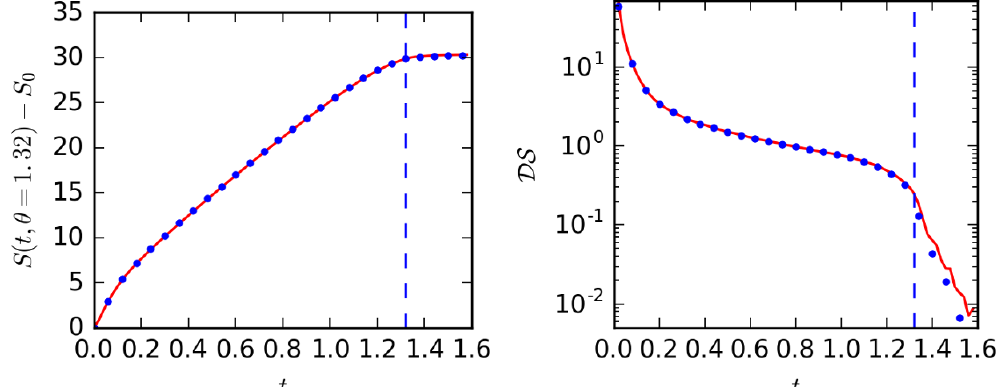
Figure 3 . Entanglement entropy (with t = 0 contribution subtracted, left) and its logarithmic time derivative (right) after a quench from (cid:22) = 10 to (cid:22) = 0 : 5, as a function of time. The polar cap has a radius of 1 : 32 rad. The blue points correspond to the results on the fuzzy sphere with N = 200 and the red line is an interpolation of the results on the commutative sphere with N = 213. The dashed vertical line indicates the expected saturation time, t = 1 :